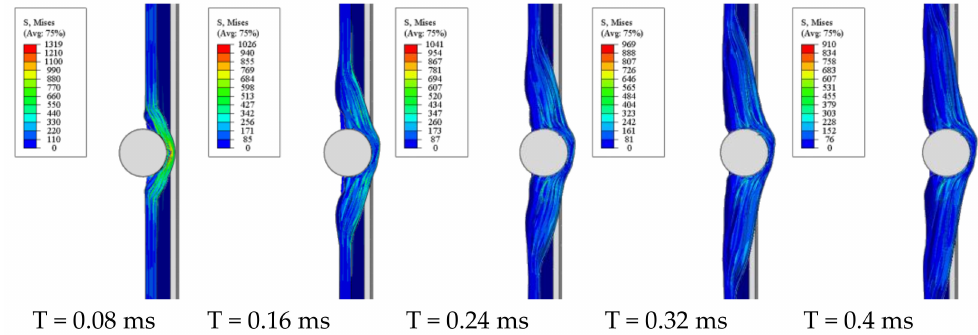
Figure 11. The process of delamination occurring and spreading in the GFRP laminate at 0–0.4ms.